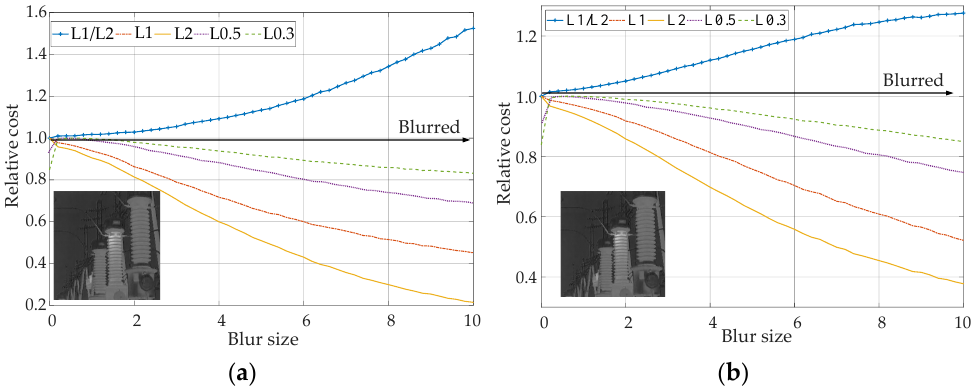
Figure 1. Reconstruction of high frequency information cost chart of image with different constraints: ( a ) high-frequency information is obtained by the transverse difference operator; ( b ) high-frequency information is obtained by longitudinal difference operator.